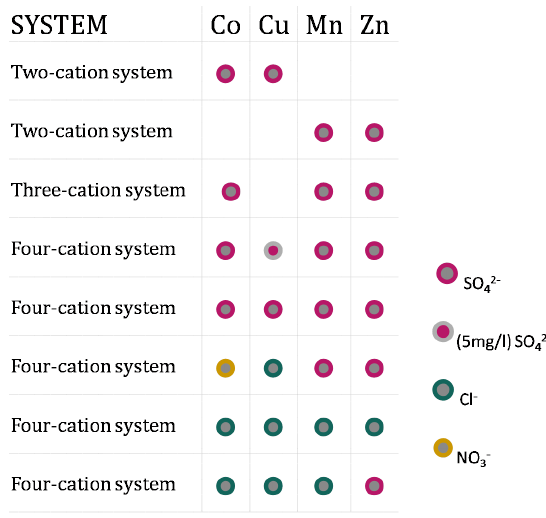
Figure 1: The scheme of biosorption experiments in multi-cation system. Different anion are marked with the different colors presented in the legend. Table 1: The parameters of the Langmuir modified model that describe the biosorption of microelements in a muli-cation system with the competition as well as parameters of the traditional Langmuir model